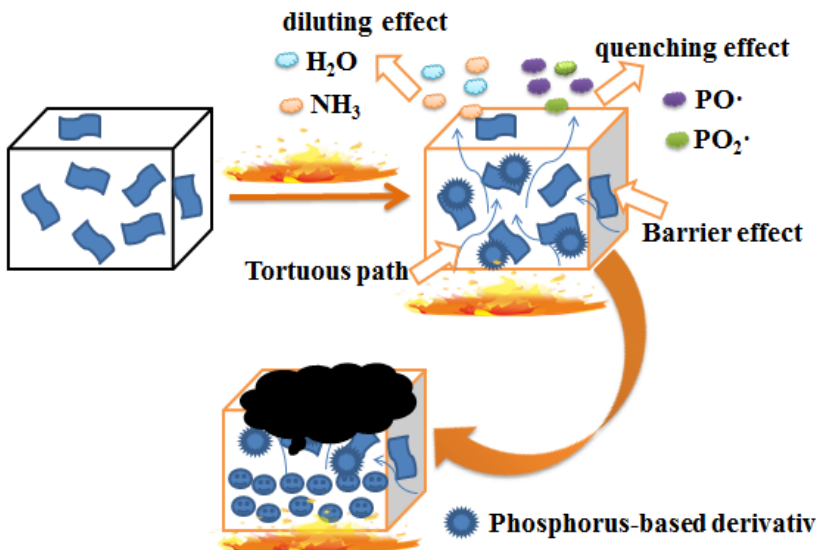
Figure 12. Proposed flame-retardant mechanism.